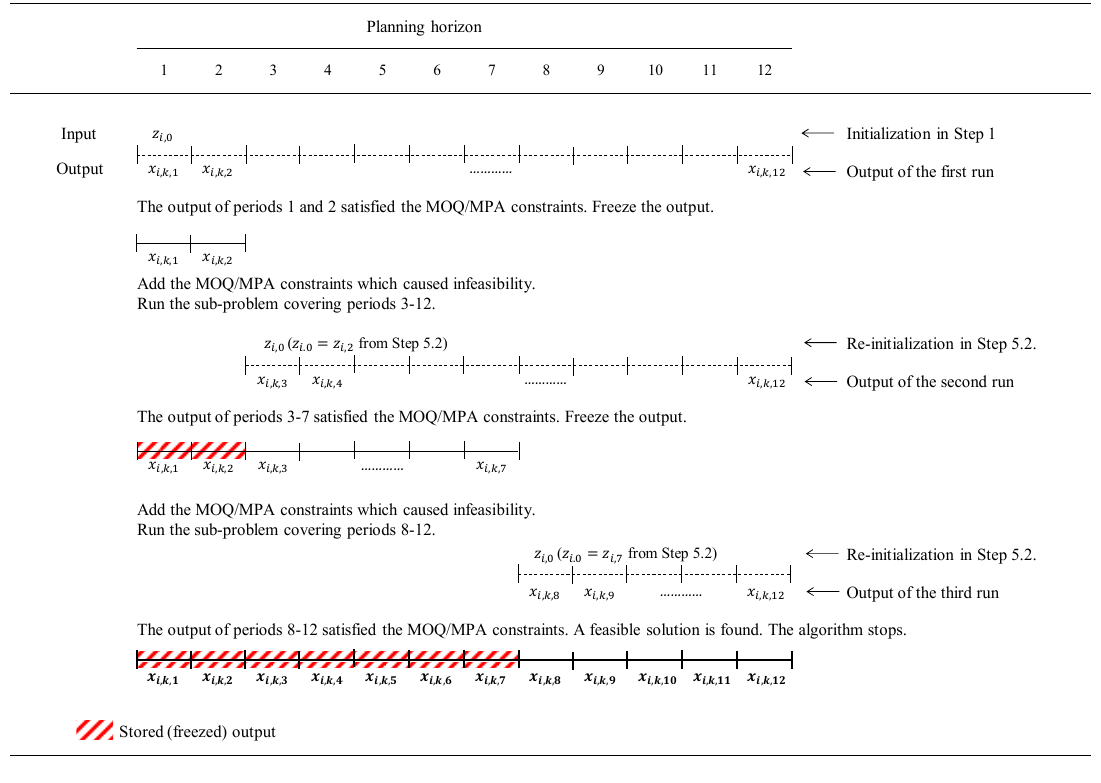
Figure 3. Implementation diagram of the BF algorithm.